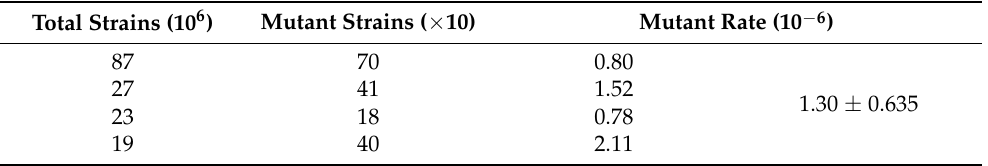
Table 4. Spontaneous mutation rate of rpsL in PCR.